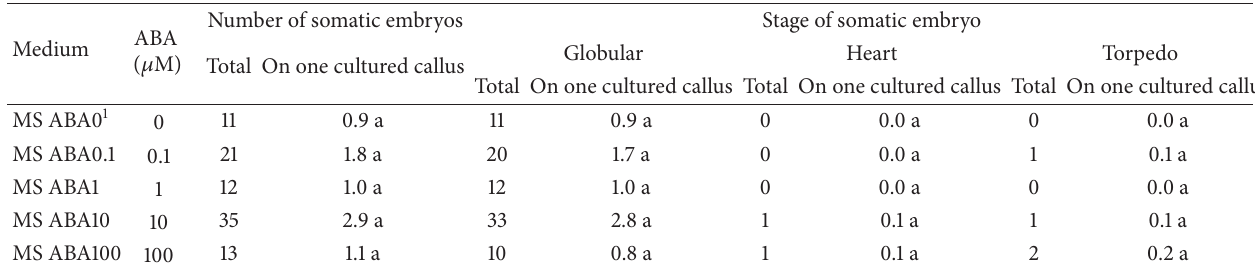
Table 3: Effect of ABA concentration on the number and the developmental stage observed in somatic embryos obtained during indirect somatic embryogenesis of C. tenuissima Ritt. forma monstruosa